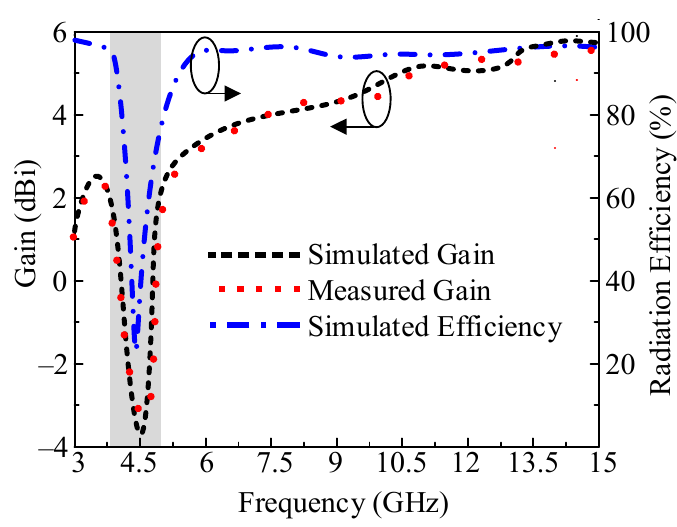
Figure 12. Gain and radiation efficiency of the proposed antenna.